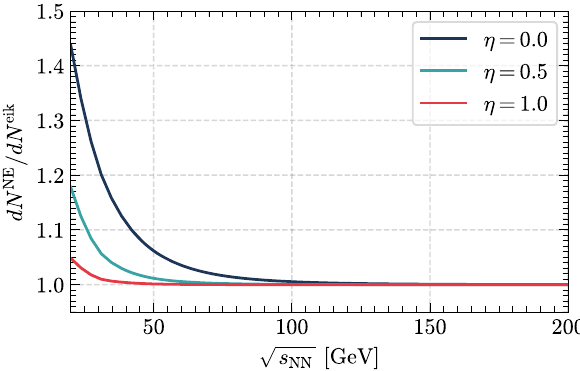
Fig. 4 Ratio of the non-eikonal single gluon spectrum, given in Eq. (4.6), with respect to the eikonal one as a function of the center- of-mass energy per nucleon for three values of pseudorapidity and for p ⊥ = 2